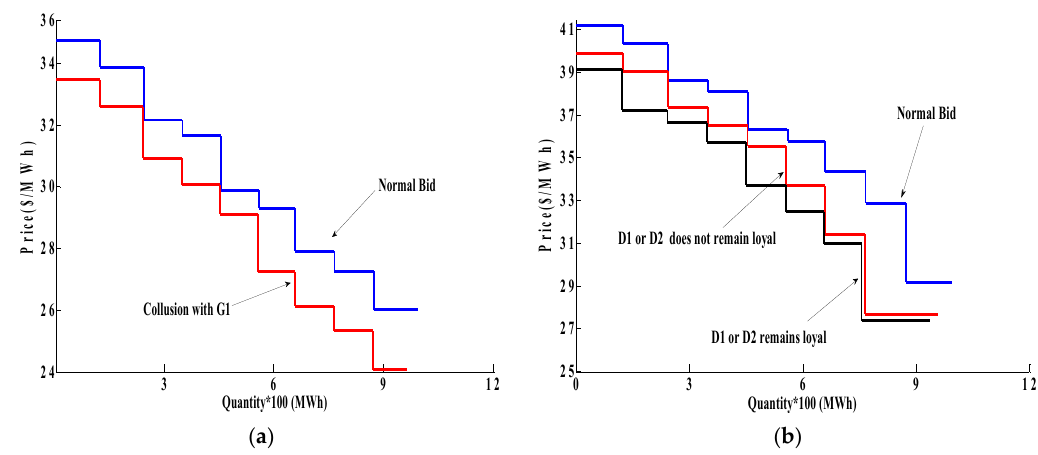
Figure 6. Bidding strategies of demand side participants: ( a ) Bids of D1 before and during collusion with D3; ( b ) cids of D3 before and during collusion with D3.